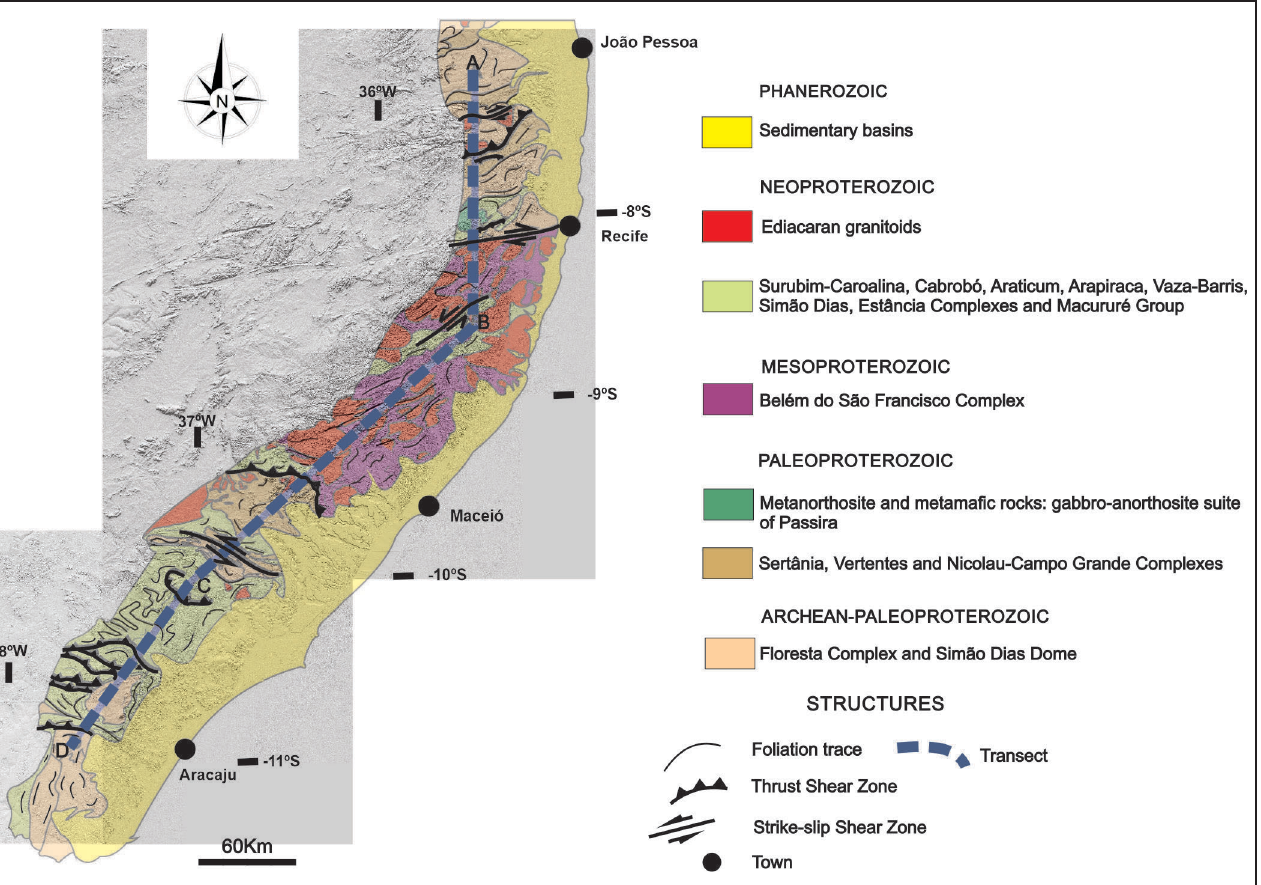
FIGURE 2 . Simplified geological map on a SRTM shadow relief emphasizing the A-D transect with identification of the main tectono-stratigraphic terrane/belts and major regional